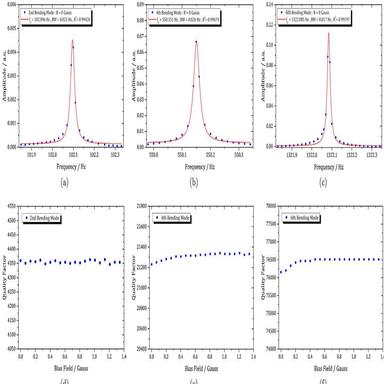
Resonance data and fitted peaks for the (a) 2nd, (b) 4th and (c) 6th bending modes of the cantilever beam. Quality factor parameter versus bias field for the (d) 2nd, (e) 4th and (f) 6th bending modes.